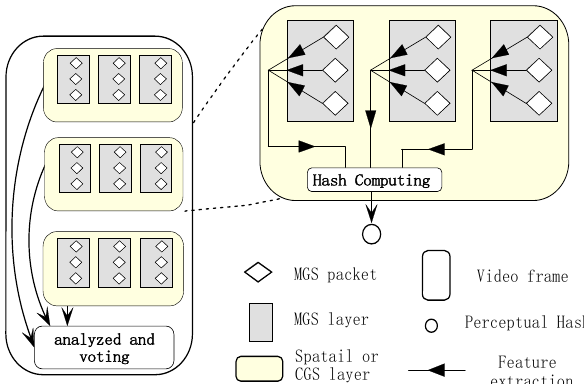
Fig.5. Authenticating a video frame from spatial and quality